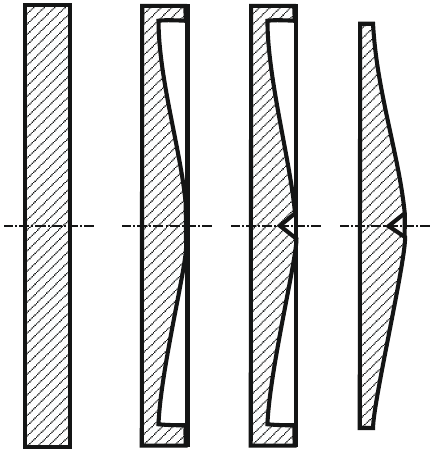
Fig. 3. Cross-section of the workpiece at different processing